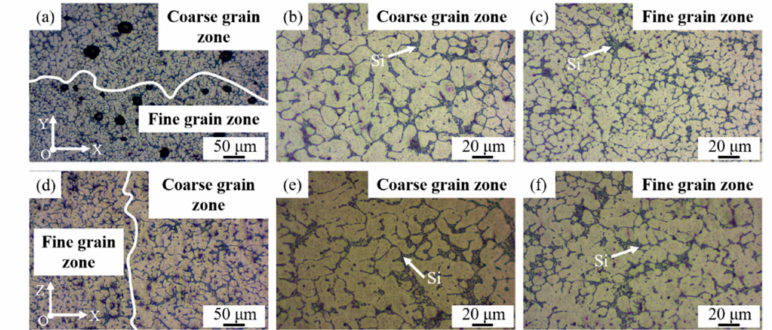
Figure 3. Metallographic morphology of the WAAM-CMT-printed TiB 2 /AlSi7Mg0.6 sample in face XOY and XOZ: ( a ) face XOY; ( b ) coarse grain zone in ( a ); ( c ) fine grain zone in ( a ); ( d ) face XOZ; ( e ) coarse grain zone in ( d ); ( f ) fine grain zone in ( d ).